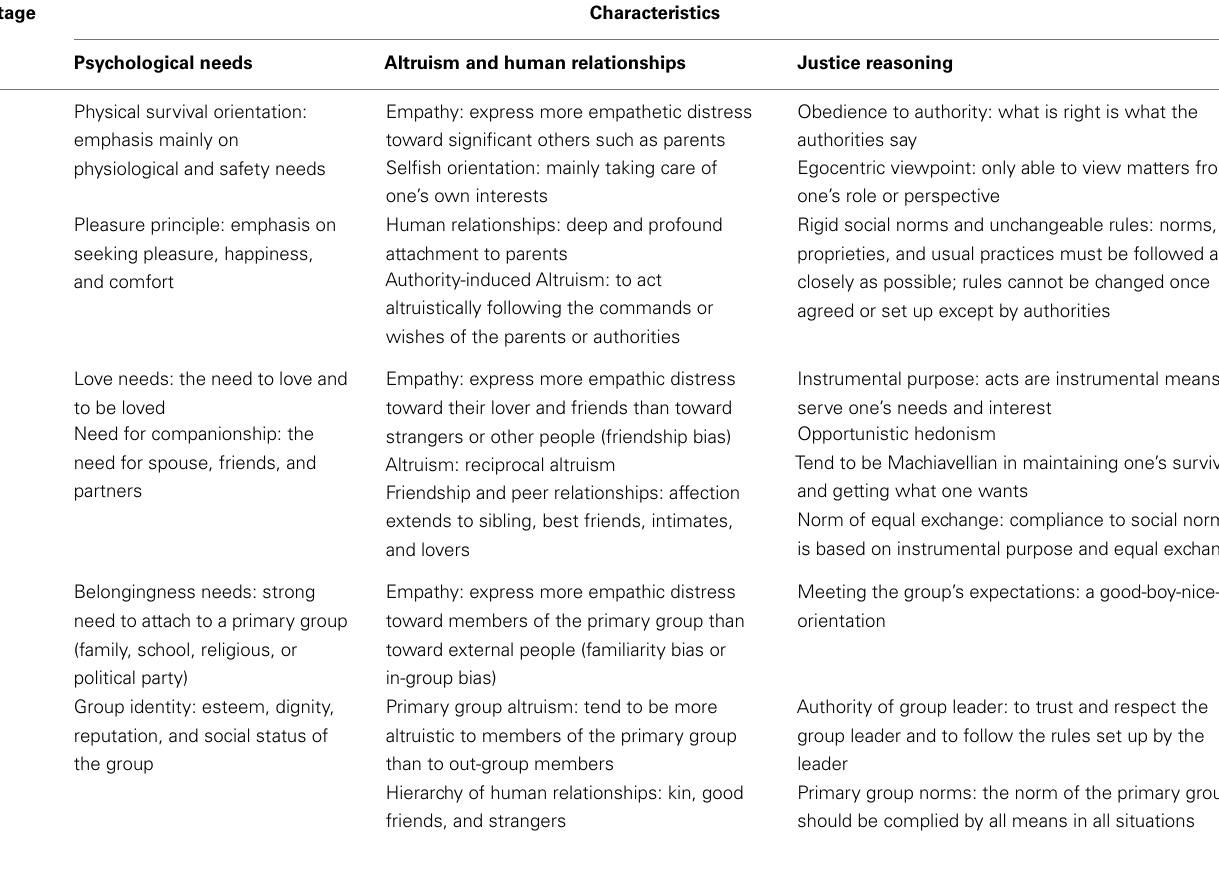
Table 1 |A summary of the stage characteristics .